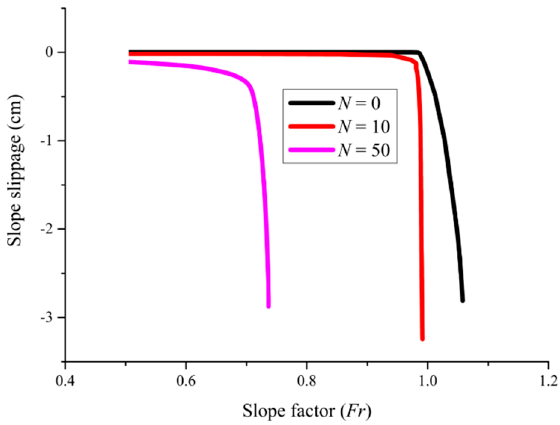
Figure 3. Trend graph of slope safety factor Fr with freeze-thaw cycles N .